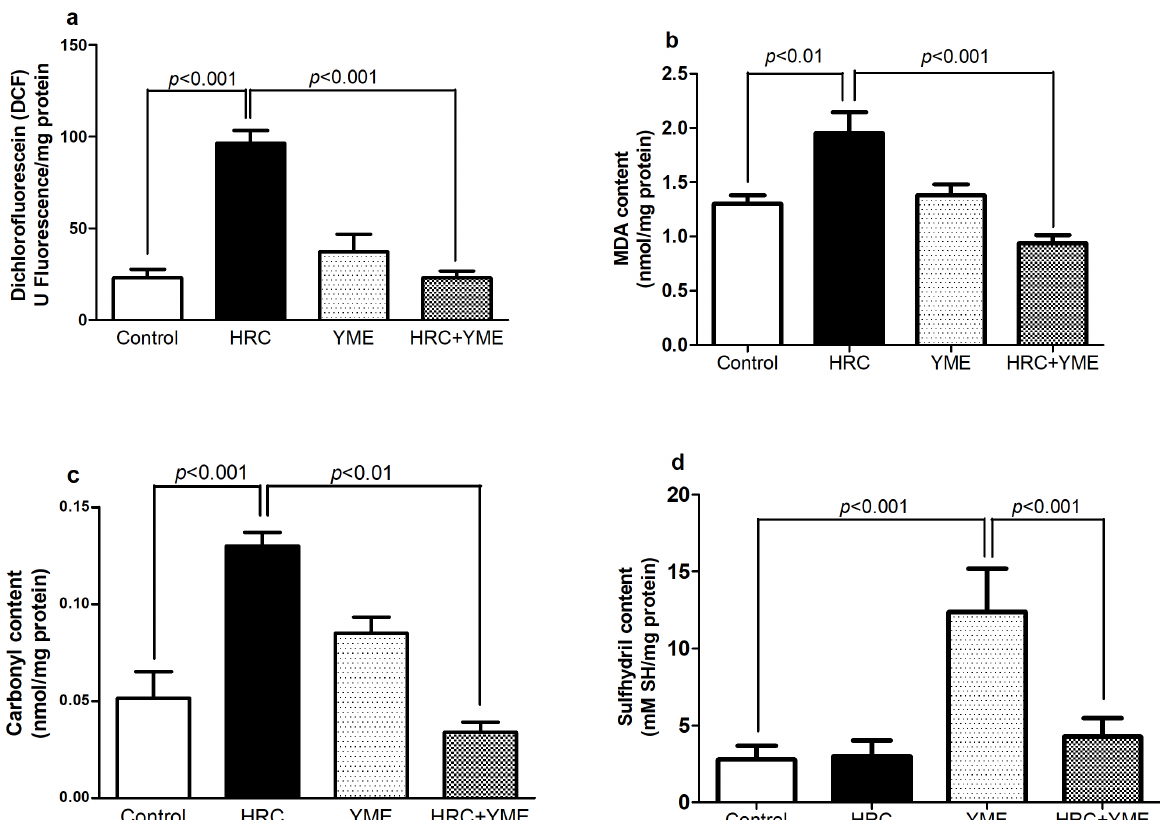
Figure 2. Oxidative stress parameters in the lungs of mice chronically exposed to hand-rolled cornhusk cigarette (HRC) smoke and treated with Ilex paraguariensis extract. The groups were compared via one-way analysis of variance (ANOVA) followed by Bonferroni post-hoc test. Statistical difference between groups was considered significant if p ≤ 0.05 and the analyses were performed using 16.0 GraphPad Prism (GraphPad Software, San Diego, CA, USA). a= DCFH oxidation; b= lipoperoxidation levels; c= carbonylation of proteins; c= total thiol